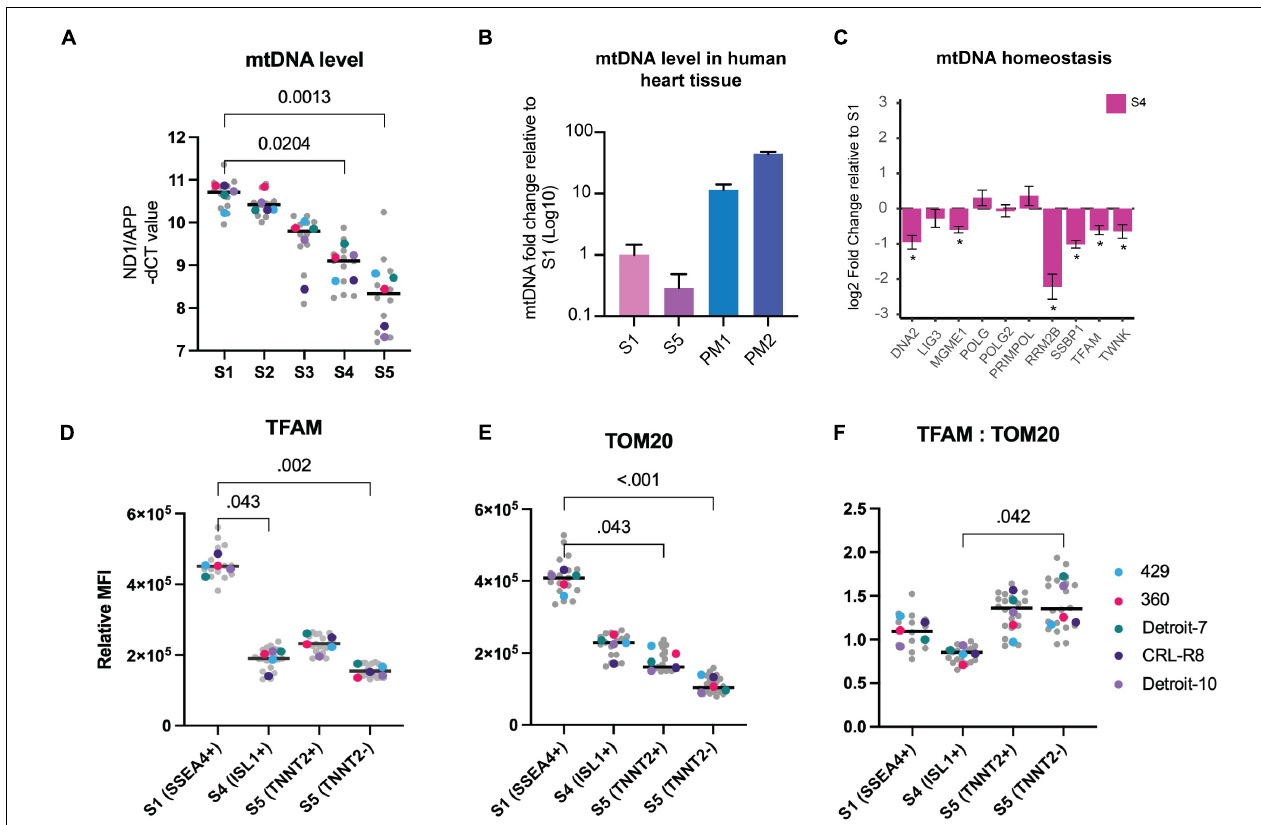
FIGURE 2 | Mitochondrial mass and mtDNA decrease progressively during mesoderm differentiation. (A) MtDNA copy number measured during mesoderm differentiation. MtDNA level was calculated by assessing the ratio of ND1 (mtDNA gene) to APP (nuclear gene). Each data point in gray reflects a single experiment (mtDNA level of a single line from one run of differentiation at a specific stage), and each colored dot represents the median mtDNA level of each line for each stage. The black line is the median of total measurements for each specific stage. Statistical significance was assessed using a nonparametric, one-way ANOVA test followed by correction for multiple comparisons (Friedman test with Dunn’s multiple comparison test), n = 5. (B) MtDNA levels were significantly lower in both S1 and S5 cells compared with human heart tissue. The bar chart shows the average mtDNA level in cells collected from five hiPSC lines in S1 and S5 and compares this with the mtDNA levels of cells isolated from postmortem heart tissues (PM1: 59 years, female, died of lung cancer; and PM2: 65 years, male, died of colon cancer). (C) We used RNA-seq from dataset A (all five lines included) to assess mtDNA homeostasis and replication machinery in Isl1 + progenitor cells. Several genes involved in mtDNA replication exhibited significant drops in S4 relative S1. (D) Using TFAM as a surrogate for mtDNA, we measured TFAM levels in different cell types across three different stages of differentiation using flow cytometry, and we detected a significant loss of TFAM at stages S4 and S5 compared with S1. There was also a significant difference in TFAM levels between TNNT2 + and TNNT2 − cells. (E) We measured TOM20 using the same methodology and found a similar significant decrease at S4, and further reduction at S5. TNNT2 + cells demonstrated significantly higher levels of TOM20 relative to TNNT2 − cells. (F) The ratio of TFAM:TOM20 increased significantly from stage S4 to stage S5 of cardiac differentiation. Since TFAM binds mtDNA in stoichiometric amounts and TOM20 reflects mitochondrial content, this suggests that mtDNA levels increased per unit mitochondrial volume. In (D–F) , each data point in gray reflects a single experiment (MFI level of a single line from one run of differentiation at specific stage), and each colored dot represents the median MFI level of each line for each stage. The black line is the median of total measurements for each specific stage. Statistical significance was assessed using a nonparametric one-way ANOVA test followed by correction for multiple comparisons (Friedman test with Dunn’s multiple comparison test), n = 5. mtDNA, mitochondrial DNA; hiPSC, human induced pluripotent stem cell; MFI, median fluorescence